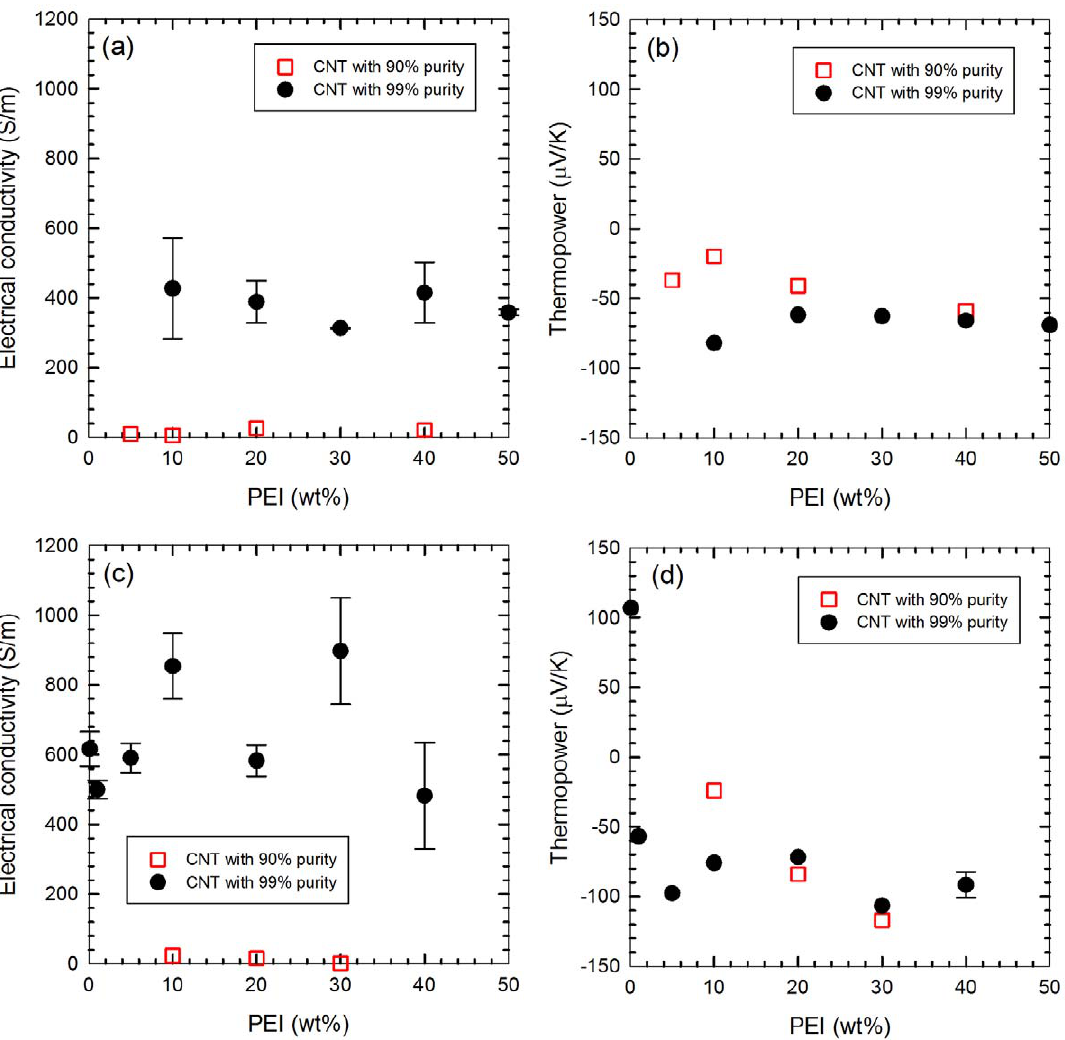
Figure 4. Effect of PEI wt% on the electrical properties for the samples containing 20-wt% (a and b: Series 2:) and 40-wt% (c and d: Series 3) SDBS. Thermopower sign changed with PEI whose concentrations between 0.1 and 1 wt%, as shown in (d), wherein it is seen that values for thermopower do not change significantly beyond 5-wt% PEI.